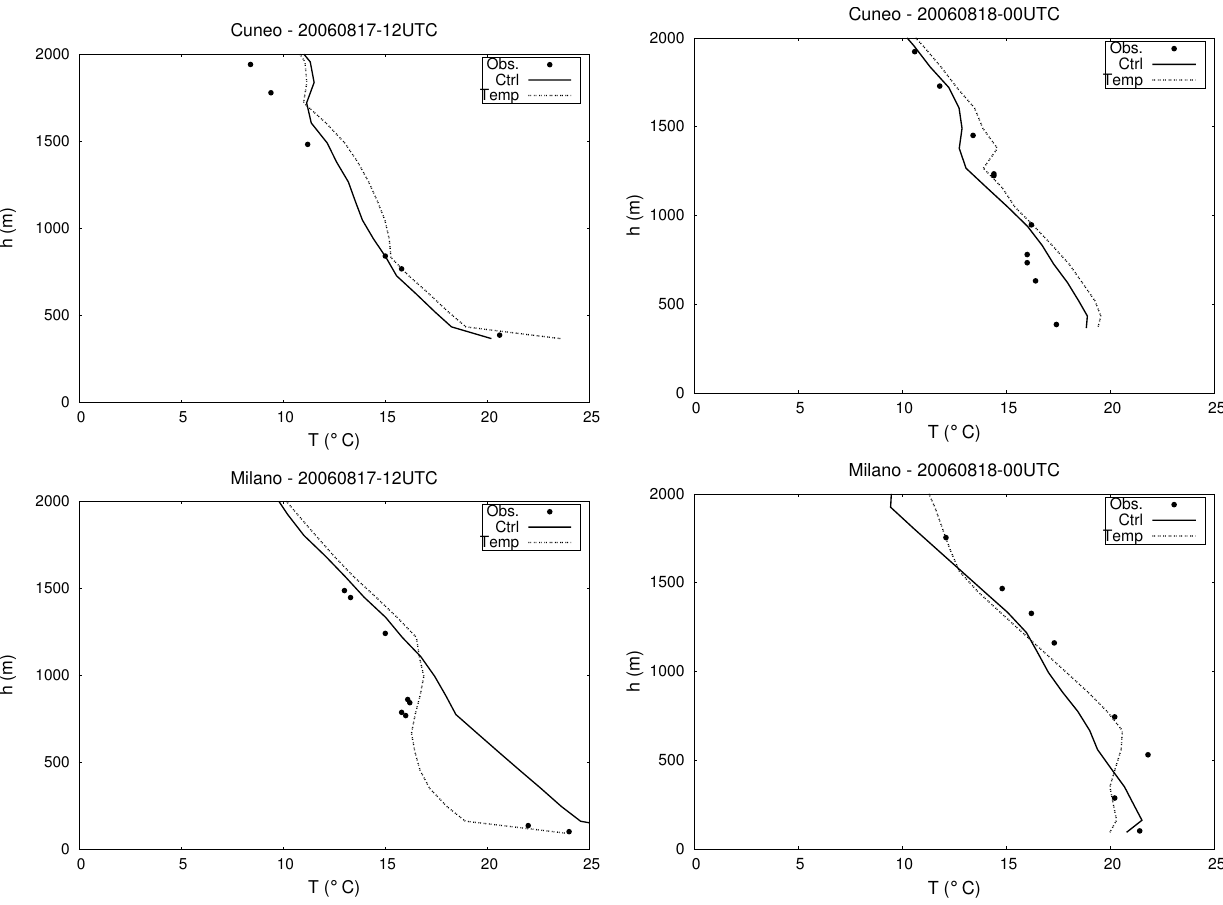
Fig. 13. Vertical temperature profile in Cuneo (above) and Milano (below), at +12h (left) and +24h (right) for the August 2006 case. The dots represent the observations, the continuous line represents the Ctrl run and the dotted line represents the Temp run.